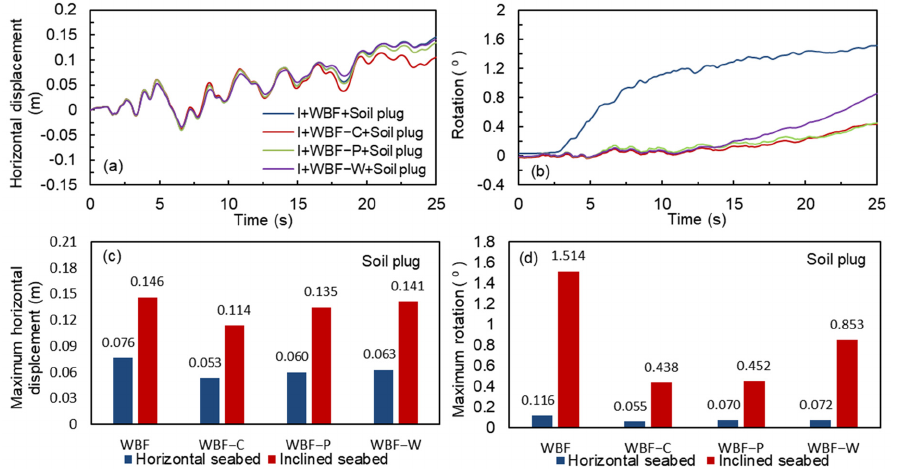
Figure 16. Response of the wide bucket foundation (WBF) with different reinforcement types in inclined seabeds: ( a ) horizontal displacement time histories of wide bucket foundation (WBF) with different reinforcement types in 50% relative density liquefiable seabeds; ( b ) rotation time histories of wide bucket foundation (WBF) with different reinforcement types in 50% relative density liquefiable seabeds; ( c ) the maximum horizontal displacement of wide bucket foundation (WBF) with different reinforcement types in 50% relative density liquefiable seabeds; ( d ) the maximum rotation of wide bucket foundation (WBF) with different reinforcement types in 50% relative density lique- fiable seabeds. The effect of reinforcement types on maximum wide bucket settlement in inclined seabeds is shown in Figure 17. The nonuniform settlement and maximum settlement of WBF-C was the smallest. The application of outer wings and inner pile can also reduce the nonuniform settlement and right corner point settlement of the bucket to some extent. Compared with the case without reinforcement, the relative settlement of the left and right corners of the bucket was reduced by 72.6%, 42.8% and 29.2% for WBF-C, WBF-P and WBF-W, respectively. The influence of the soil plug and reinforcement methods on bucket settlement was similar to that for the horizontal displacement and rotation. Figure 17. The maximum settlement of the wide bucket foundation (WBF) with different reinforce- ment types in 50% relative density inclined seabeds. 0.031